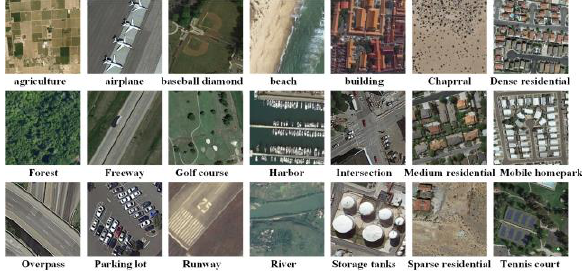
Figure 5. Examples of each class in the NWPU-RESISC45 dataset for single-source domain